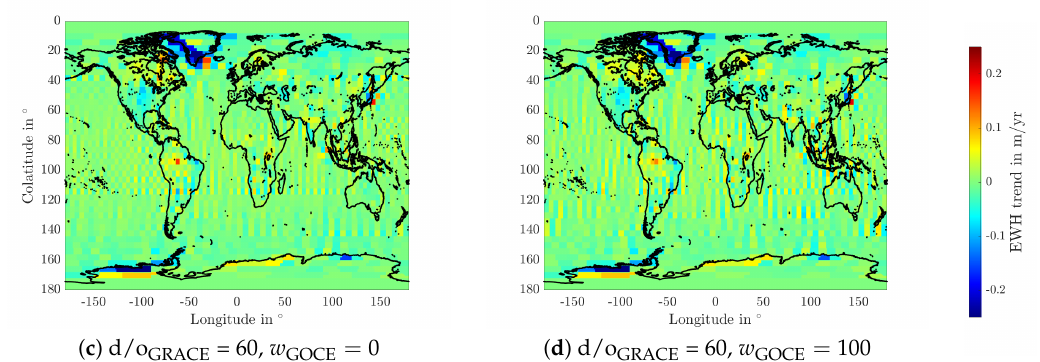
Figure 14. EWH trends for the GOCE data period, computed by the mascon approach based on GRACE-only ( a , c ; models are from in [8]) and GRACE/GOCE SGG combination models ( b , d ). In panels ( a , b ), GRACE SH coefficients have been included up to d/o 45, while in panels ( c , d ), GRACE coefficients have been included up to d/o 60. In the computation of the GRACE/GOCE SGG combination models, the GOCE normal equation (NEQ) system is overweighted by a factor of w GOCE = 100 (see Section 2.2.4). In the model shown by panel ( a ), the GRACE NEQs are extended by zero-coefficients up to d/o 60 (with a weighting of w hf = 10 30 according to the method described in Section 2.2.5), to achieve a